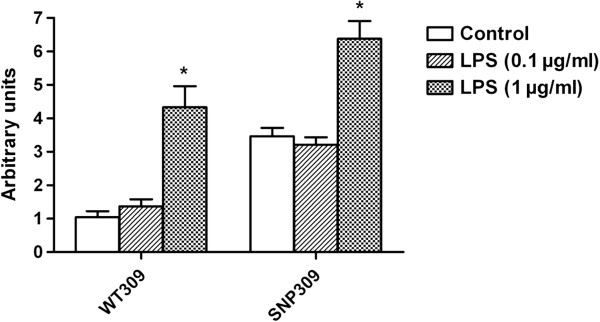
Combined effect of transfection with MDM2 SNP309 (T > G) polymorphism and H. pylori lipopolysaccharide (LPS) on transcriptional activity of MDM2 in AGS cell. WT309, cells transfected with allele 309 T; SNP309, cells transfected with allele 309 G; * P < 0.01, compared with WT309 or SNP309, where appropriate.